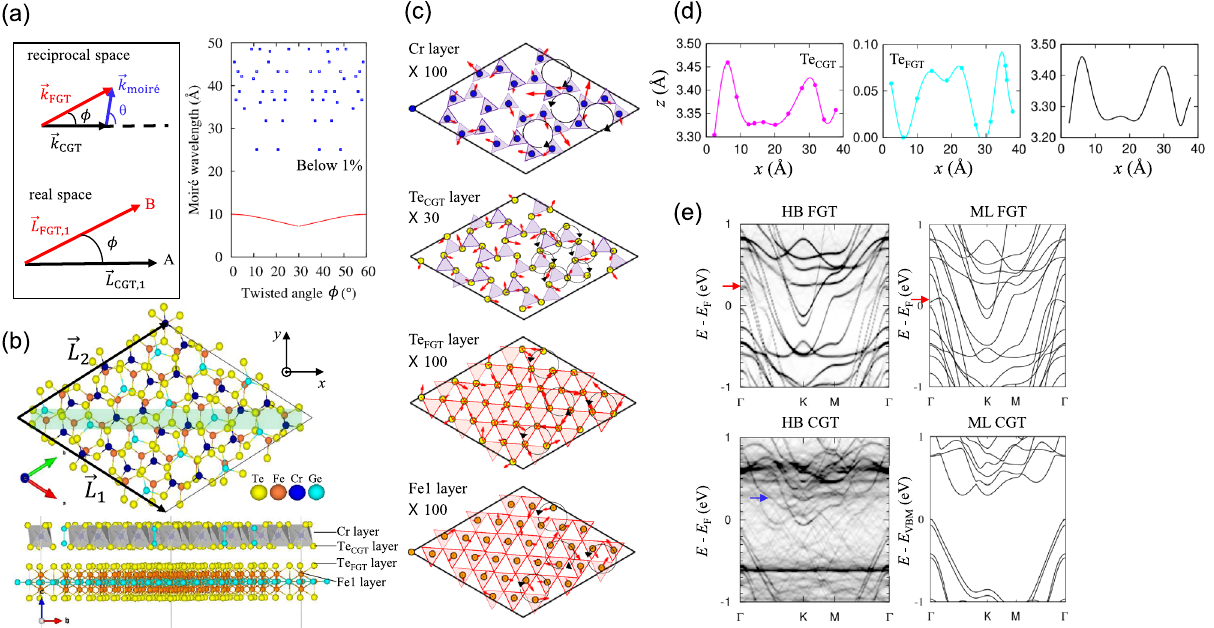
Figure 1. ( a ) −→ k wave vectors of monolayer (ML) Fe 3 GeTe 2 (FGT) and ML CrGeTe 3 (CGT) in reciprocal space, moiré lattice vectors in real space (left panel), and moiré wavelength as a function of twist angles (red lines, right panel). ( b ) Top and side views of twisted moiré lattice with a moiré lattice constant of 25.02 Å, a lattice mismatch △ of 0.55%, a twist angle φ of 11.39°, and ( m , n , p , q ) = (1, 3, 3, 4). Only Fe1, Te FGT , Te CGT , Ge CGT , and Cr atoms near the interface are depicted in the top view. ( c ) In-plane displacement vectors (red arrows) of Cr, Te CGT , Te FGT , and Fe1 layers. The atomic structures are obtained using the spin-polarized optB88 vdW method. The red arrows are enlarged to 30 or 100 times their original size. The purple (red) triangles comprise the interface Te CGT (Te FGT ) atoms. ( d ) Z -coordinates of interface Te atoms along a diagonal in the x -axis (left and middle panels) and interlayer distance between Te FGT and Te CGT atoms (right panel). ( e ) Unfolded band structures of moiré heterobilayer calculated by the noncollinear PBE + U + SOC method when U = 3.5 eV and J = 1.0 eV. They are drawn along the unit-cell bandlines of FGT (HB_FGT) and CGT (HB_CGT). The moiré heterobilayer has a ferromagnetic (FM) spin alignment between the FGT and CGT layers. For comparison, the band structures of ML FGT and ML CGT are shown. The red and blue arrows indicate differences between the moiré heterobilayer and the